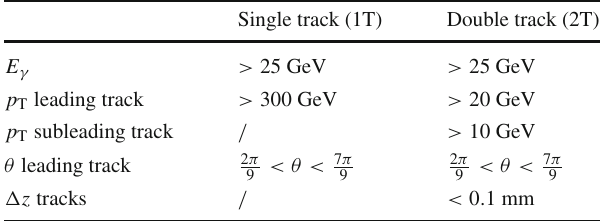
Fig. 16 Same as Fig. 6, but for real scalar WIMPs. Left: scalar 3-plet. Right: scalar 5-plet